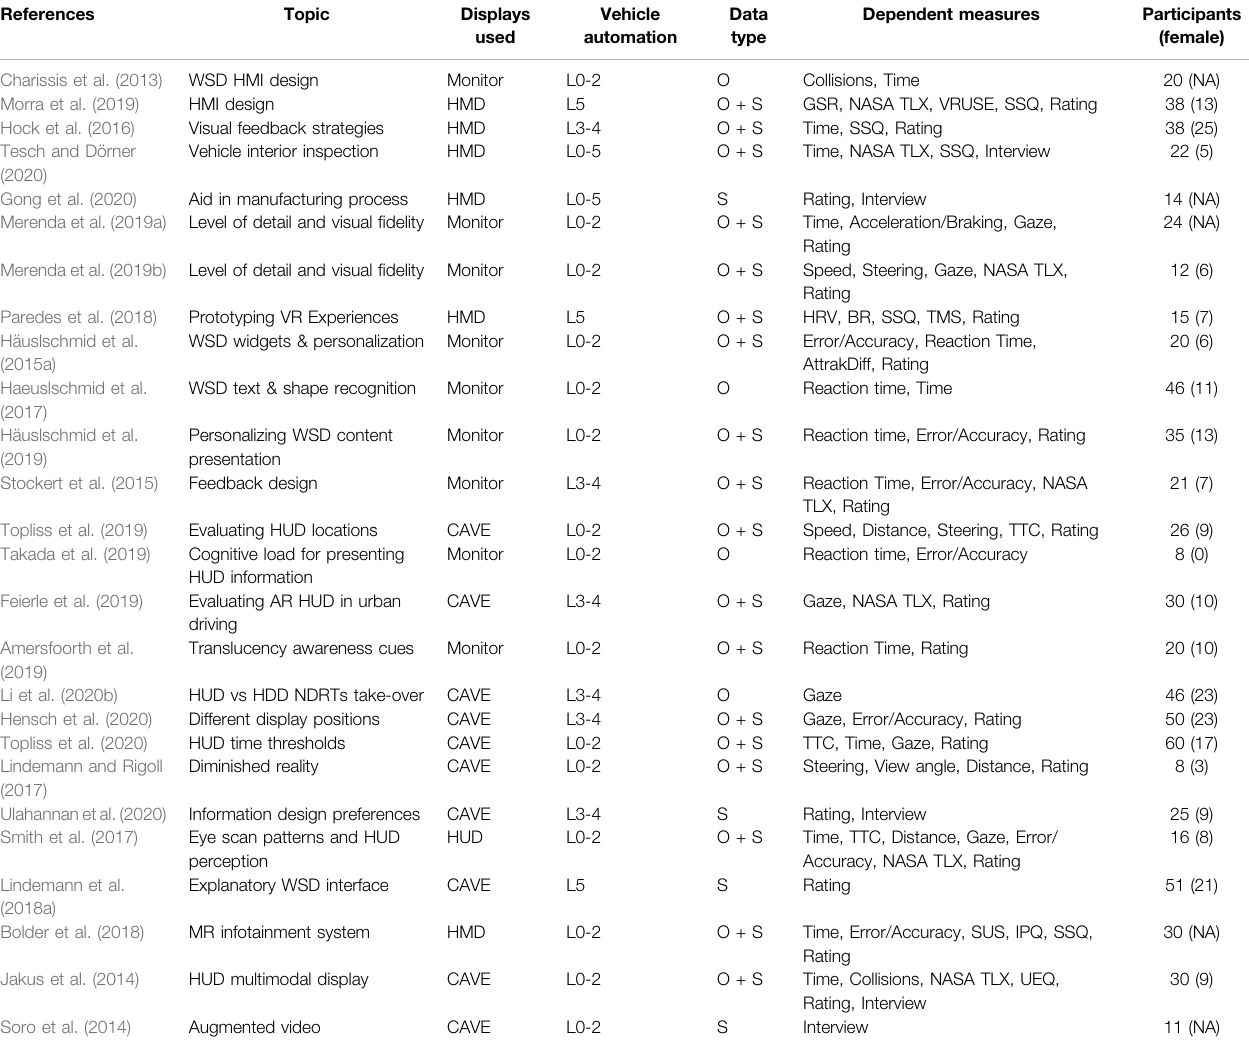
TABLE 7 | Summary of user studies in UI Design and Prototyping